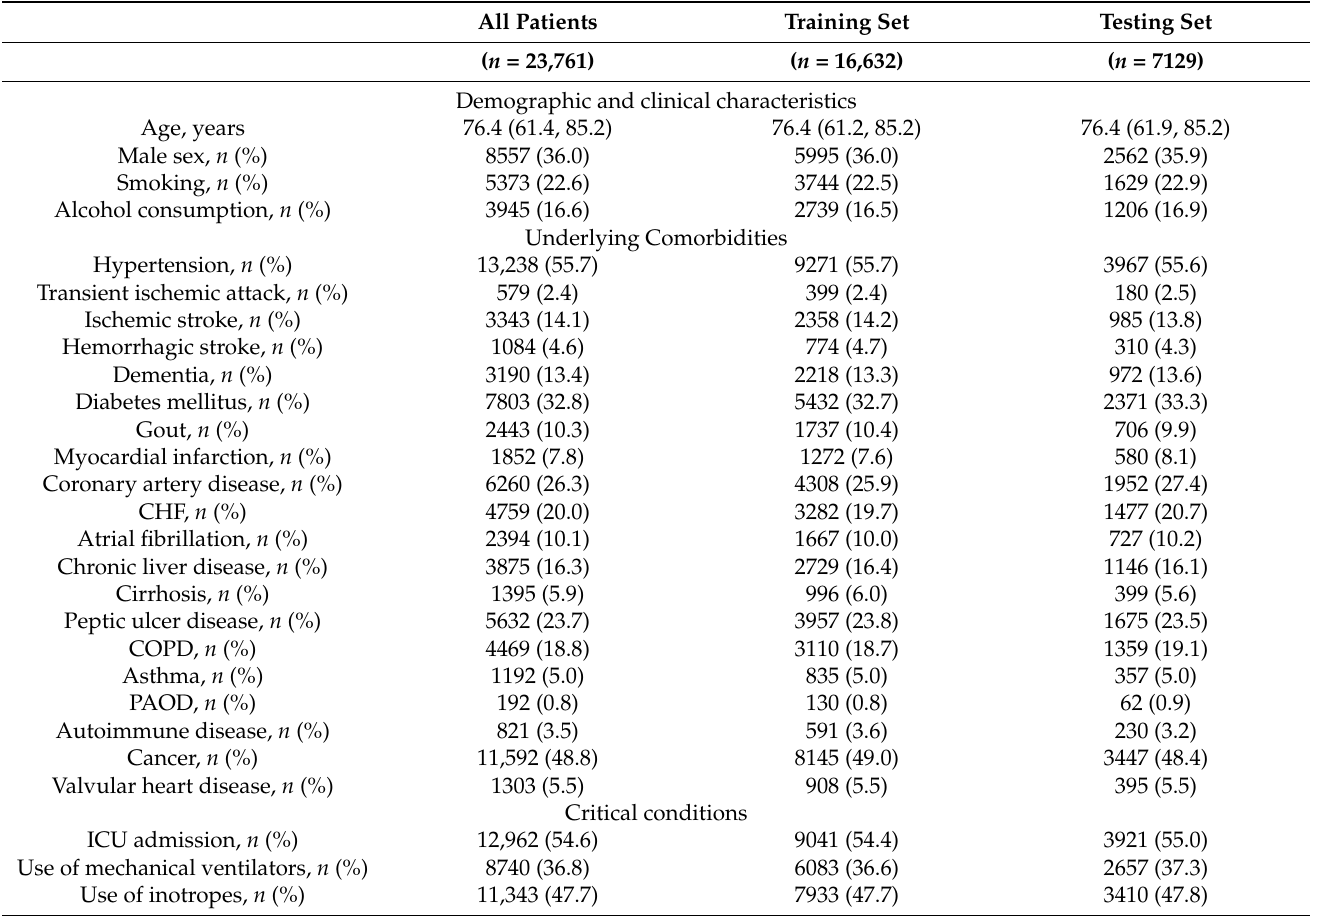
Table 1. Clinical features and classes in sepsis survivors divided into training and testing dataset. All Patients Training